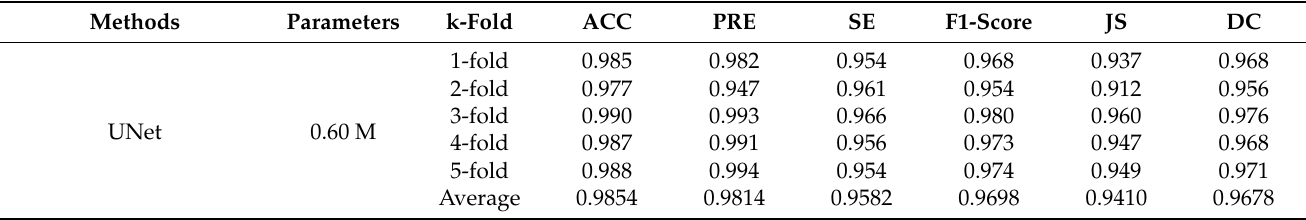
Table 3. Experimental results of proposed methods for lung segmentation and comparison against other existing methods. The bold data denotes the best